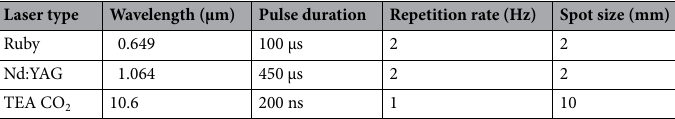
Table 1. The main parameters of the lasers used.